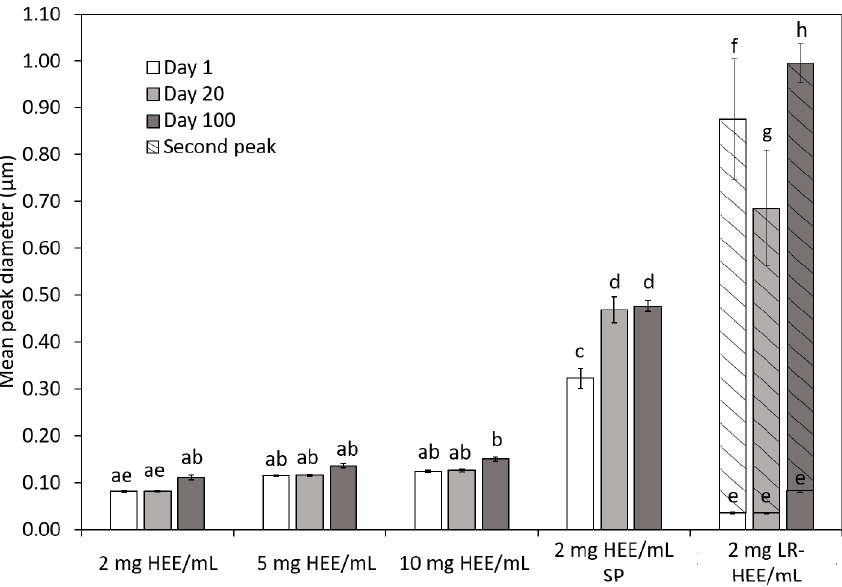
Figure 4. Mean peak diameter on day 1, day 20 and day 100 for the particles suspensions from 2, 5 and 10 mg HEE/mL magnetically stirred and 2 mg HEE/mL processed with syringe pump (SP) and from the 2 mg LR-HEE/mL ethanol magnetically stirred colloidal particle dispersions. Mean peak diameters relate to mean individual particle peaks, omitting aggregation peaks at 3.5–5.6 µm as explained in the main body text. LR-HEE showed a smaller and a larger mean individual particle peak identified by solid and dashed bars respectively. Different letters indicate statistically significantly different diameters, p = 0.05, ANOVA.